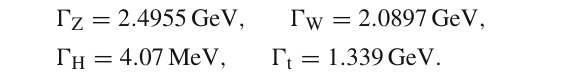
Table 8 Event selections used for the Rivet analyses for the V + jets distributions, where m W Cut